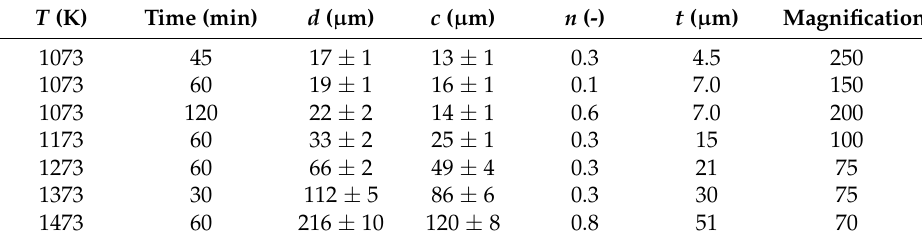
Table 1. Mean grain size ( d ), crystallite size ( c ) and number of annealing twin boundaries per grain ( n ) after heat treatment at different temperatures and times. d only takes into account the intercepts with grain boundaries, whereas c is determined by counting intercepts with both grain and annealing twin boundaries.